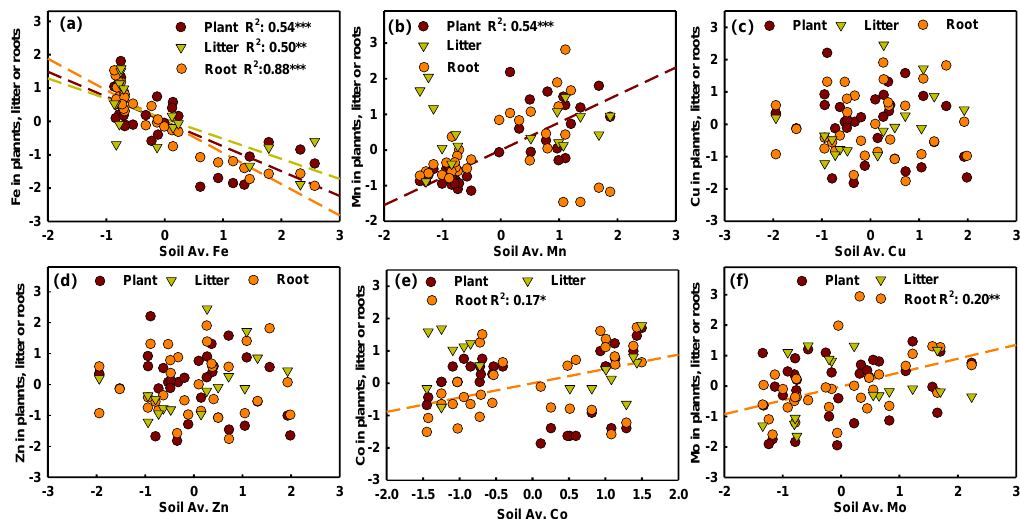
Figure 5. Relationships of soil-available Fe, Mn, Cu, Zn, Co, and Mo with their corresponding contents in aboveground plants (purple points), litter (green triangles) and roots (orange points). Note: The results (R 2 and p value) of linear regression are shown at the top of each figure using the corresponding color and symbols. *, **, *** indicates significant linear relationship at p < 0.05, 0.01, 0.001, respectively. Only significant items are shown.